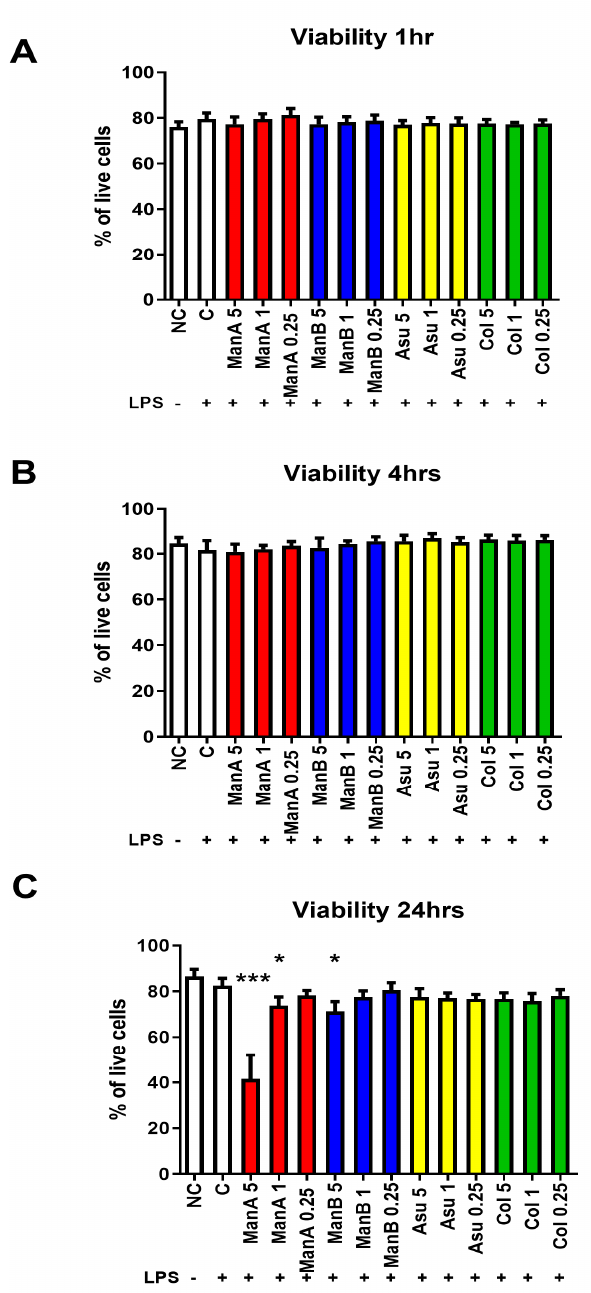
Figure 2. The impact of di ff erent manumycin-type metabolites on the viability of THP-1 cells. To assess the possible toxicity of manumycin-type metabolites, the viability of THP-1 cells was tested by Trypan blue using light microscopy at di ff erent time points. ( A ) viability of THP-1 cells after 1 h stimulation; ( B ) viability of THP-1 cells after 4 h stimulation; ( C ) viability of THP-1 cells after 24 h stimulation. Statistical significance values indicated as follows: * p ≤ 0.05, *** p ≤ 0.001. Sample legend: